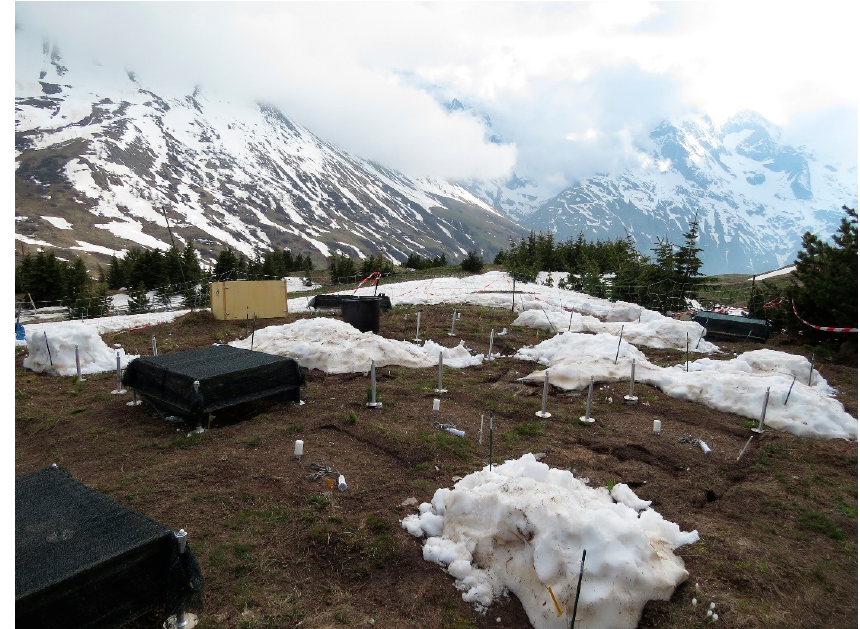
Figure 1. Experimental setup to study the effects of snowmelt timing and sky exposure on tree seedling performance near the alpine treeline at Lautaret Alpine Botanical Garden, French Alps. Early plots are already snow-free and some are covered by shade roofs (which are moved to night-warming plots each night). Piles of snow still cover the late plots. Photo by Hannah Loranger.